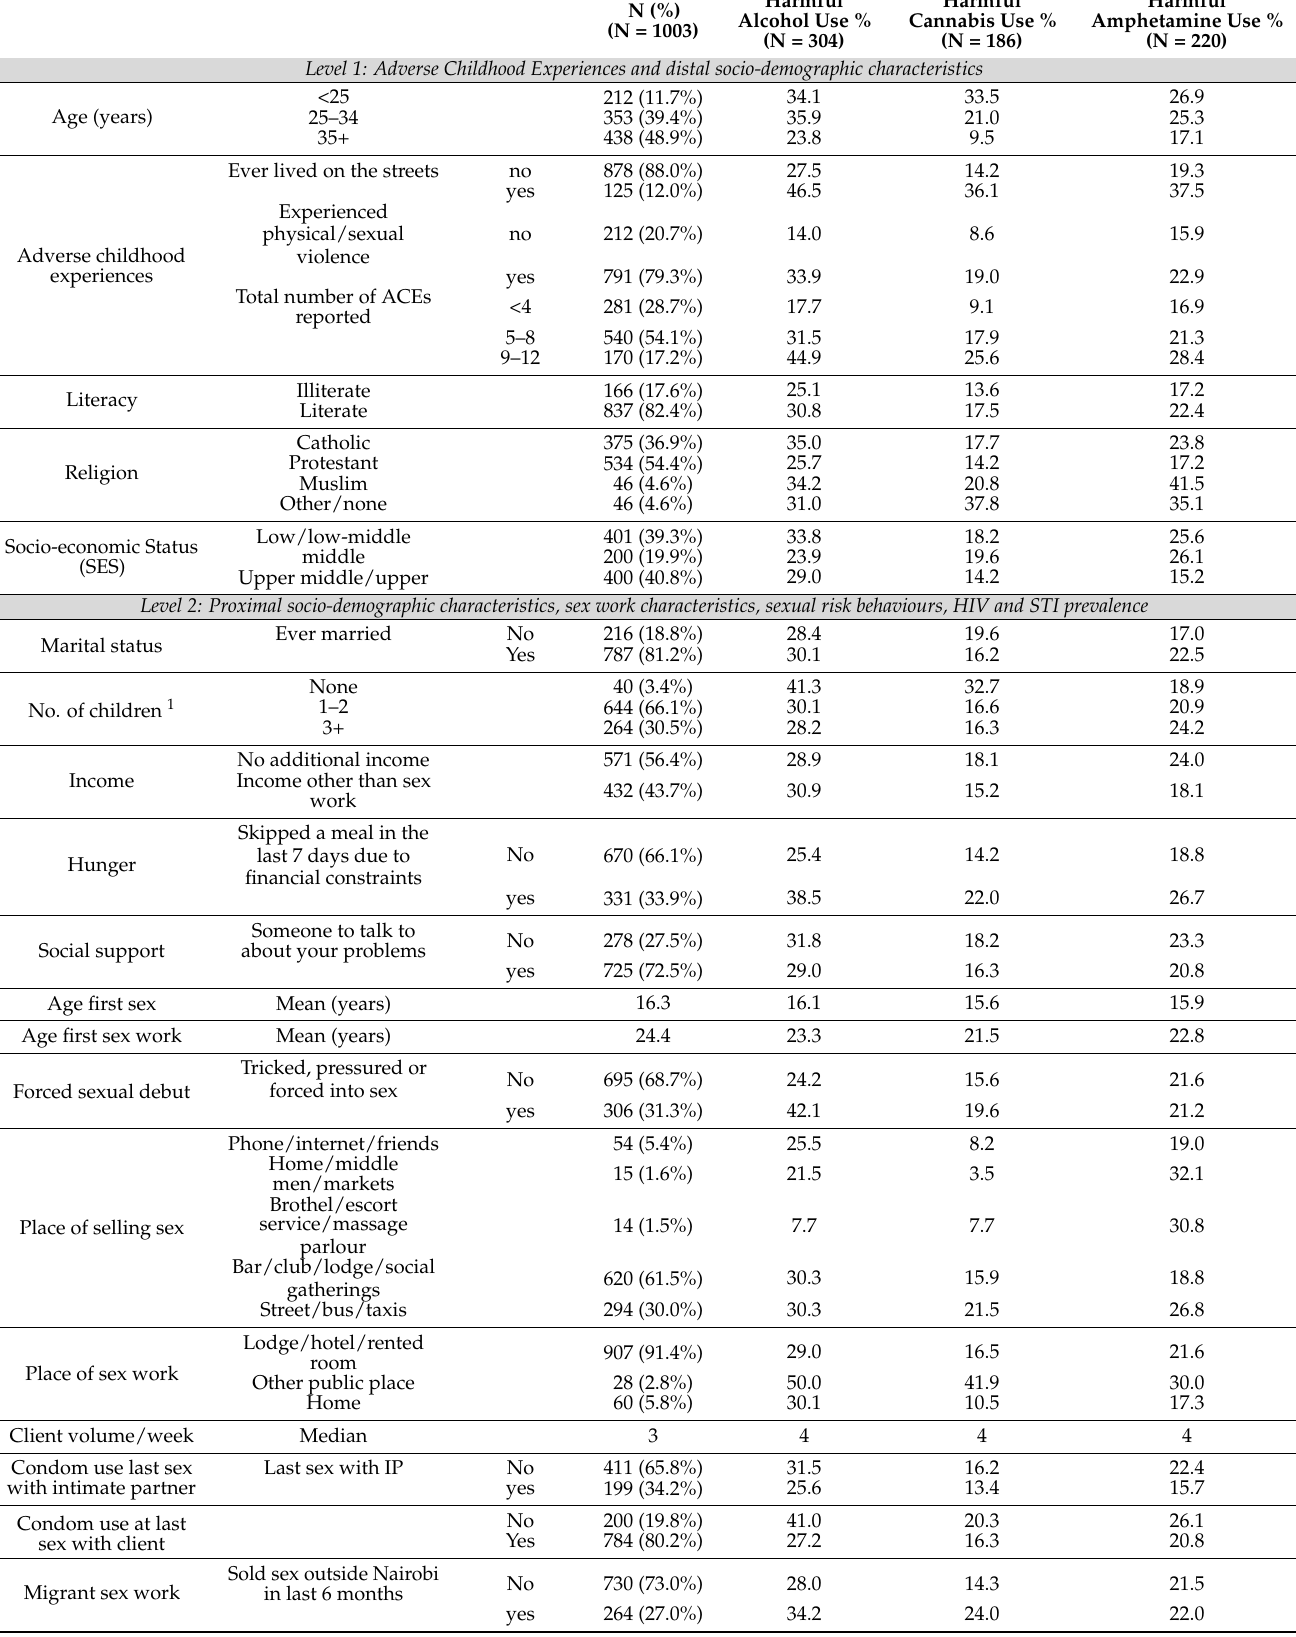
Table 1. Study sample characteristics and associations with harmful alcohol and other substance